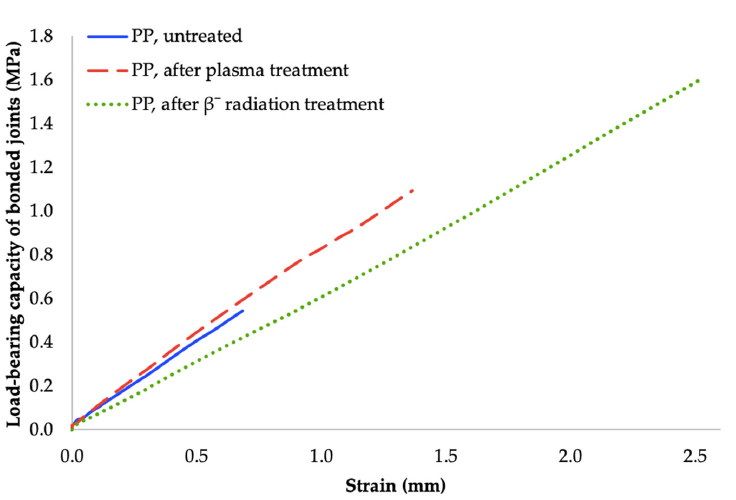
Figure 11. Dependence of bonded-joint load-bearing capacity of adhered joints on strain (cyanoacrylate adhesive).